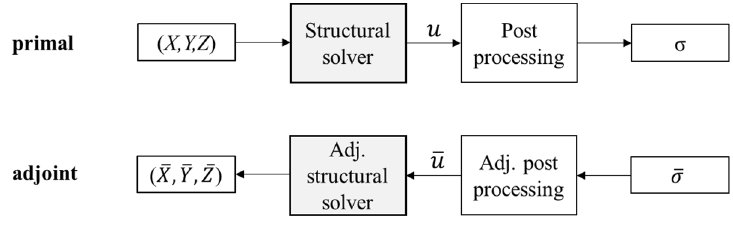
Figure 7. Evaluation by mechanical solver: primal and adjoint modes.